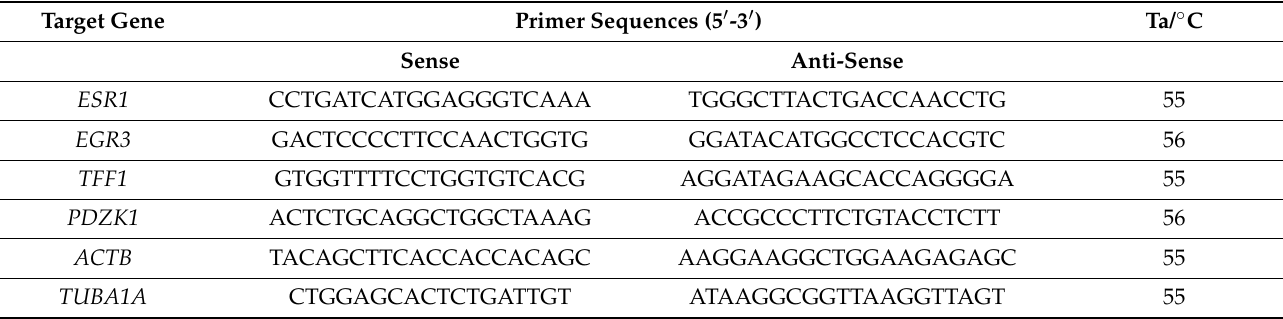
Table 4. Primer sequences and qPCR conditions for housekeeping and target